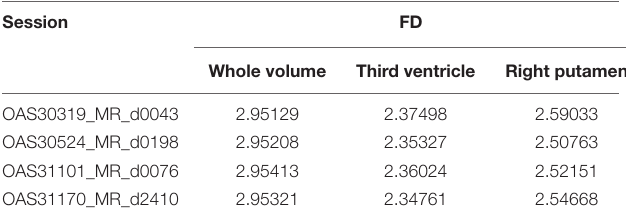
TABLE 3 | Box-counting FD testing on multiple sessions corresponding to various subjects. Session FD Whole volume Third ventricle Right putamen OAS30319_MR_d0043 2.95129